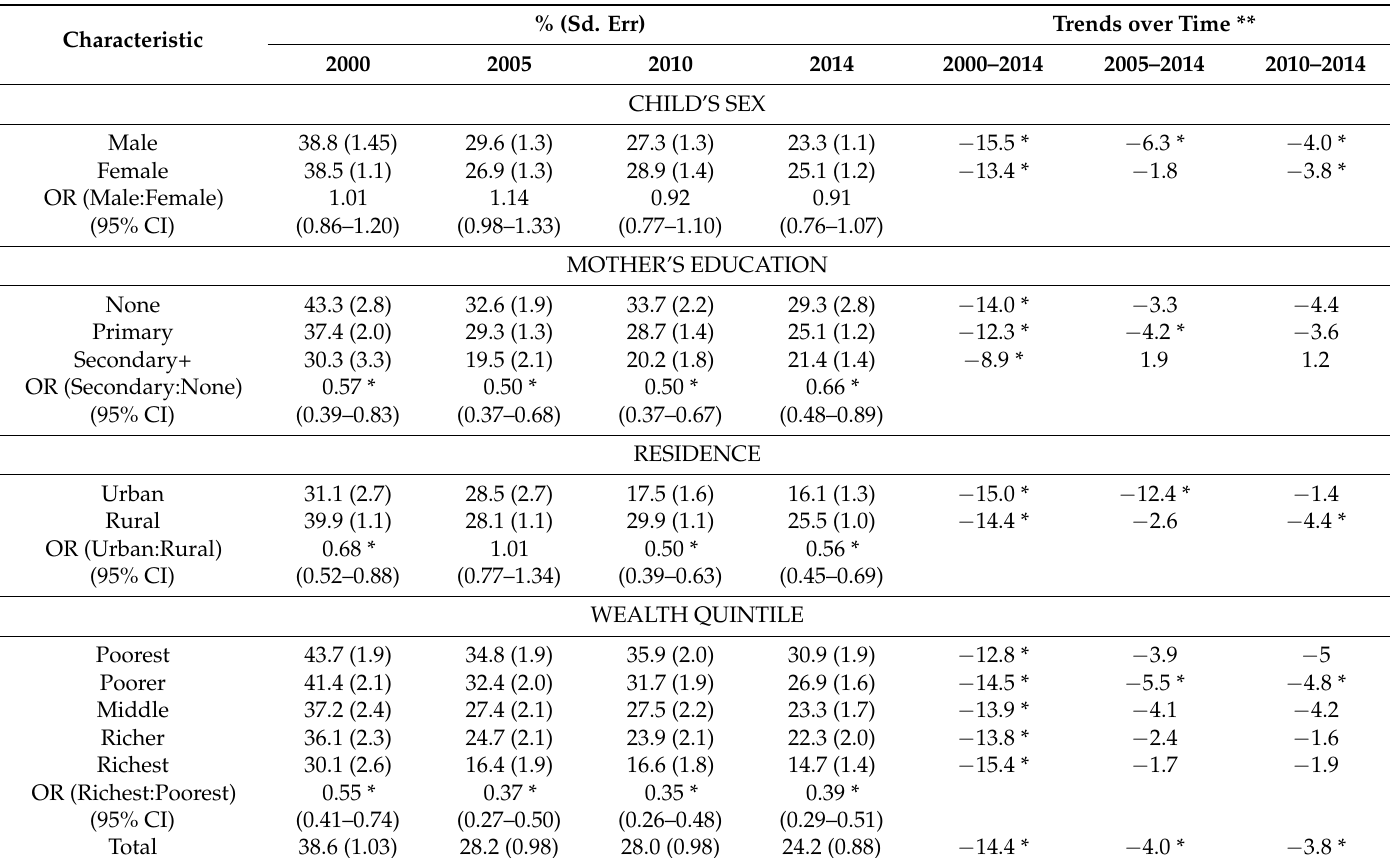
Table 4. Prevalence of underweight in children in the four surveys according to their social characteristics.